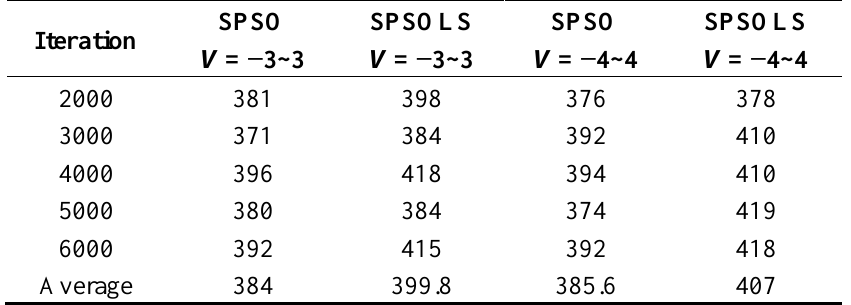
Table 4. Performance comparison among SPSO and SPSOLS (SPSO with local search) ( c = 2.05, c = 2.05, w = 0.72984). 1 2